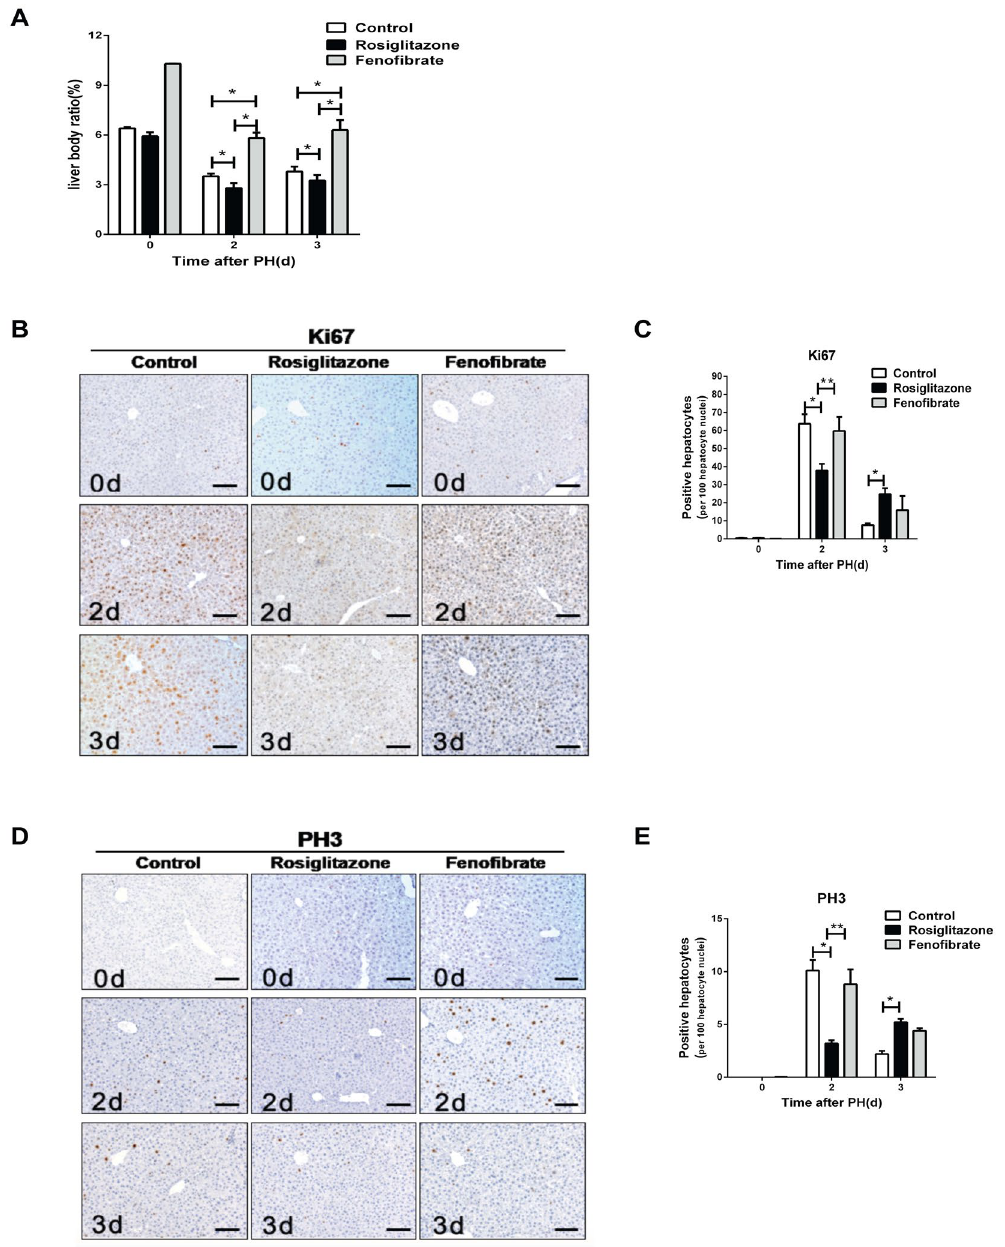
Figure 3. PPAR α activation does not influence hepatic regeneration following partial hepatectomy ( A ) Liver to body weight ratio in untreated mice, rosiglitazone-treated mice, and fenofibrate-treated mice at different time points after PH. ( B ) Representative IHC pictures of hepatic Ki67 expression after PH. ( C ) Quantification of Ki67-positive hepatocytes. ( D ) Representative IHC pictures of Ki67 expression after PH. ( E ) Quantification of Ki67-positive hepatocytes. * p < 0.05, ** p <